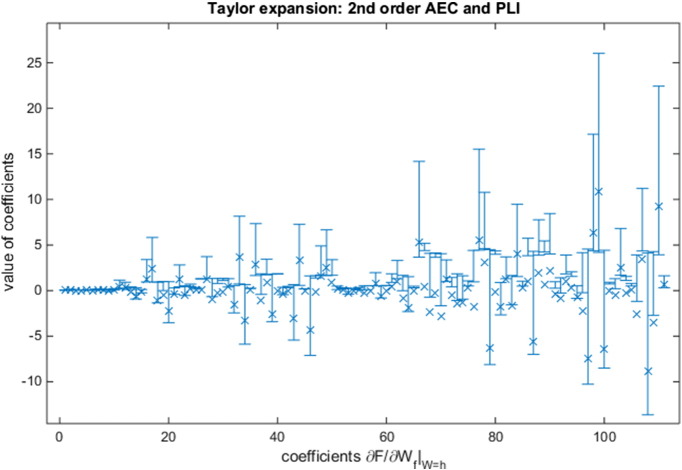
Regional contribution of individual MEG frequency bands (PLI; first dataset). The linear approximations based on individual frequency bands (model a) are shown in more detail. The upper panel illustrates the predicted connections, where the threshold for the number of connections is based on the R2. The bottom panel shows the predicted average connectivity per ROI, i.e. node strength/degree. Note that the predicted networks are sparser than the AEC predictions (Fig. 5). Nevertheless, the beta and alpha show more occipital and temporal connection patterns, whereas theta and gamma show more frontal and parietal connections. The PLI gamma band shows a distinct pattern compared to its AEC counterpart, where a fronto-temporal pattern of connections could be observed.